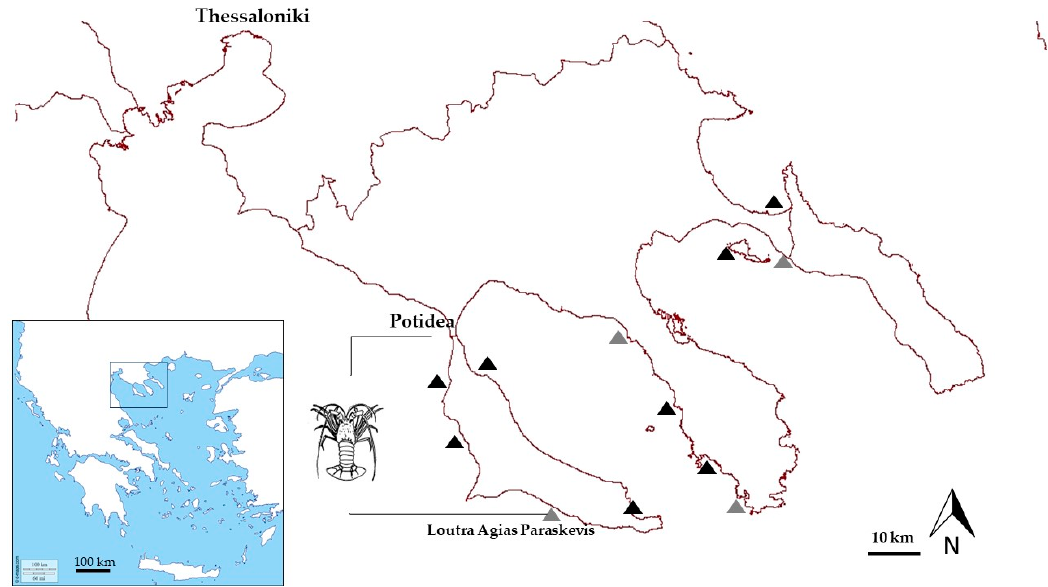
Figure 1. The study area. The fishing operations are marked with the lobster icon. Black triangles indicate the locations that successful interviews with fishermen were undertaken, while grey triangles represent the unsuccessful ones.